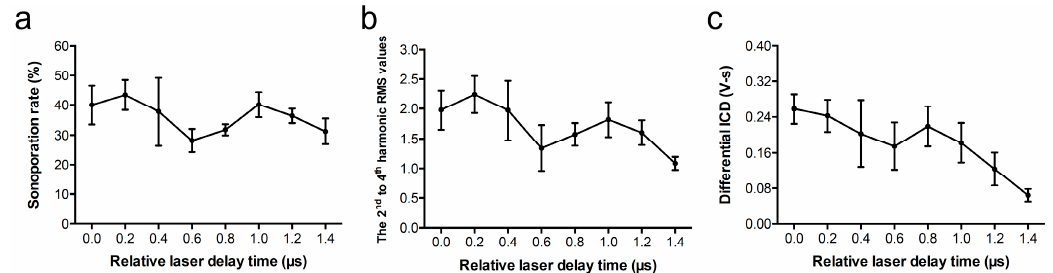
Figure 9. Sonoporation of BNL cells triggered using ultrasound and laser simultaneously. ( a )